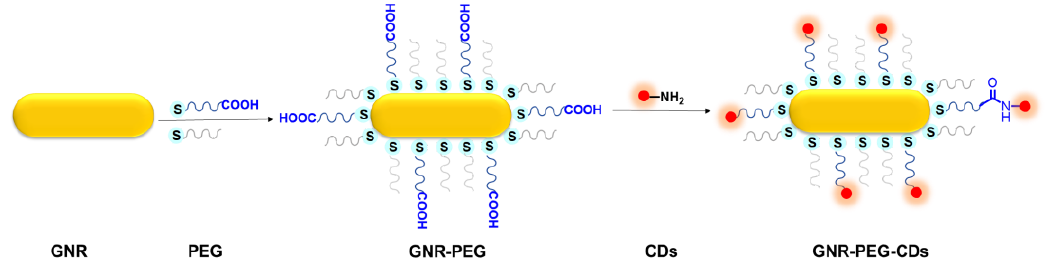
Scheme 1. Schematic illustration of GNR–PEG and GNR–PEG–CDs.